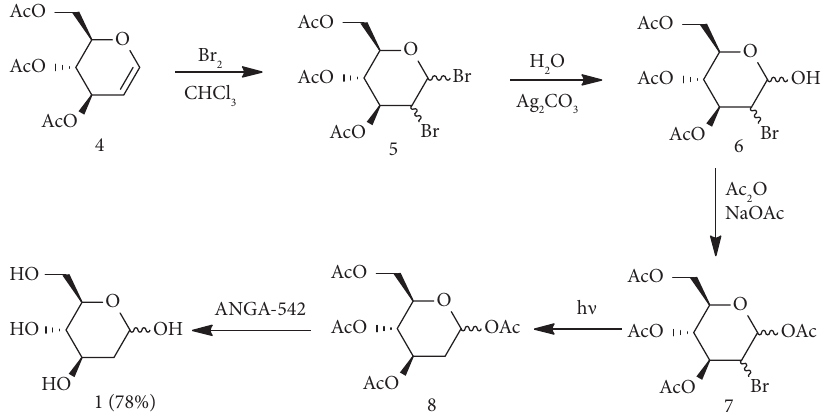
Figure 5: Preparation of 2-DG by photolysis of α and β anomers of 7 .